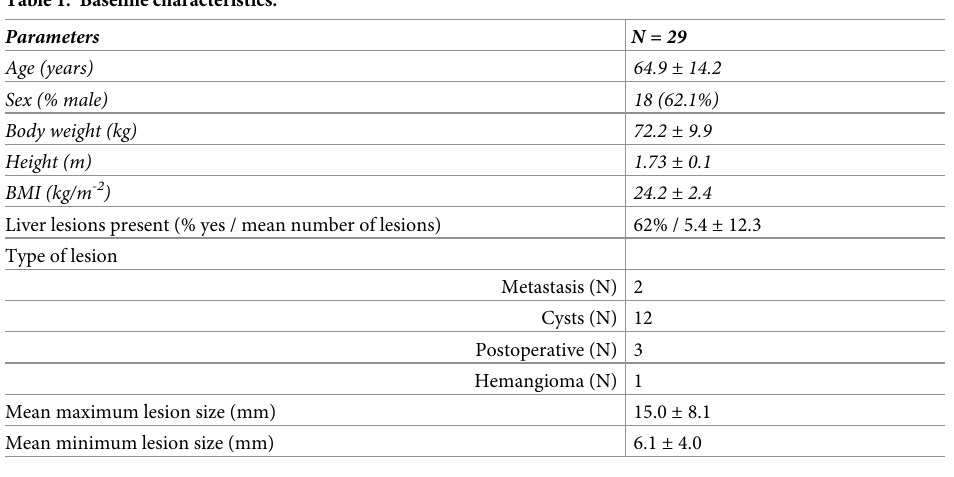
Table 1. Baseline characteristics.